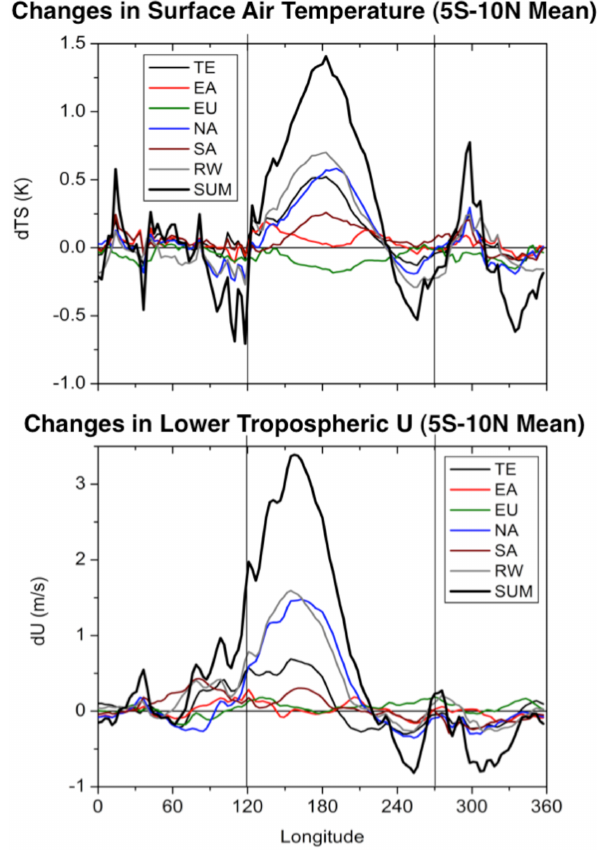
Fig. 6. Meridional mean (5S to 10N) of BC-caused anomalies of: (the upper panel) surface air temperature (K), and (the lower panel) lower tropospheric zonal component of wind speed (m/s) derived from various model runs. Results are all year 41–60